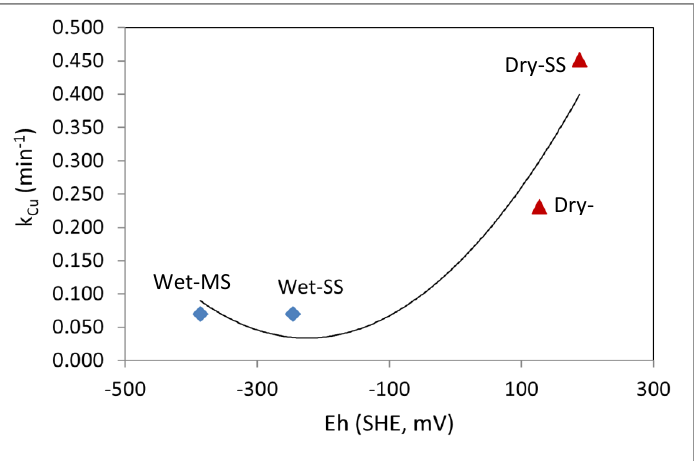
Figure 2. The relationship between pulp redox potential and flotation rate of Cu after different milling conditions.